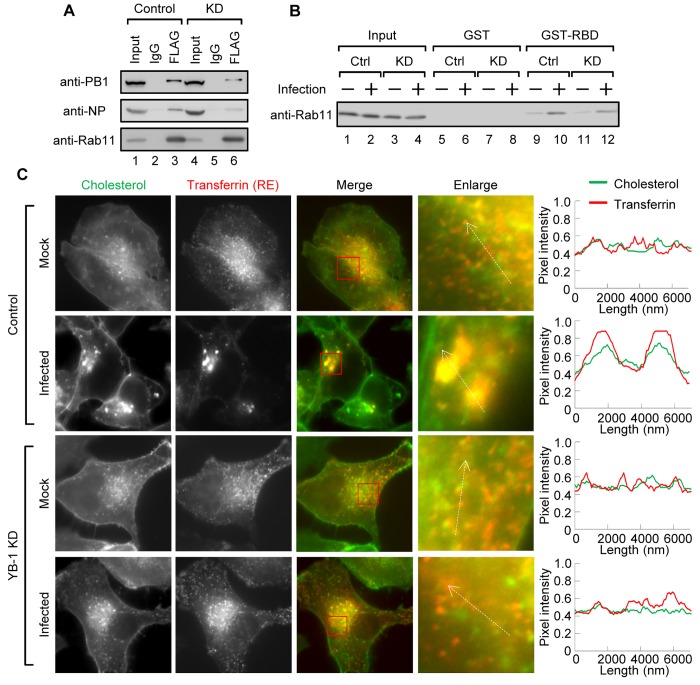
The pericentrosomal ERC is important for the enrichment of vRNP and cholesterol.(A and B) Association of vRNP with Rab11a in YB-1 KD cells. At 48 h post transfection with either non-targeting or YB-1 siRNA, HeLa cells constitutively expressing FLAG-Rab11a were infected with influenza virus at MOI of 10. At 8 h post infection, cells were subjected to immunoprecipitation assays with either non-specific IgG or anti-FLAG antibody (panel A) and GST pull-down assays using GST-RBD (panel B) as descried in Fig 2, respectively. Co-precipitated proteins were analyzed by western blotting with anti-PB1, anti-NP, and anti-Rab11a antibodies. (C) Accumulation of cholesterol in ERC in infected cells. At 48 h post transfection with either non-targeting or YB-1 siRNA, HeLa cells were infected with influenza virus at MOI of 10. At 6 h post infection, cells were pulse-labeled with 100 μg/ml of transferrin conjugated with Alexa 568 (red) for 30 min at 37°C, followed by incubation without Alexa 568-labeled transferrin for 30 min. After fixing in 4% PFA, cells were incubated with 200 μg/ml filipin to visualize cholesterol (green). In panel C, quantitative determination of the each signal (cholesterol, green; transferrin, red) was performed along the white dashed arrows shown within the panel C, enlarged panels. Y-axis indicates the normalized pixel intensity.